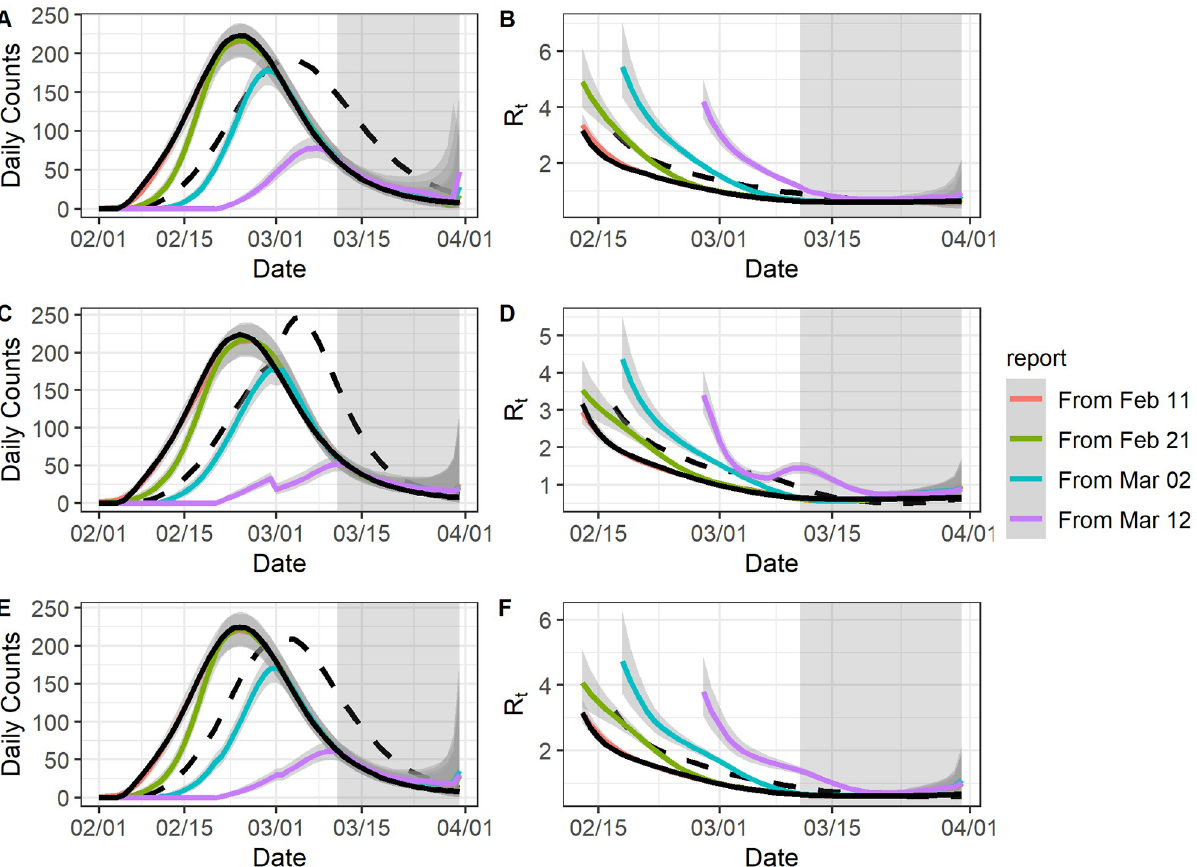
Fig 3. The model fit for data with no early report. For all graphs: the black solid curve corresponds to estimates based on the known epidemic curves and the black dashed curve corresponds to estimates based on the reported curves. The grey-shaded region superimposed on the curve depicts the 95% Bayesian credible interval and the grey-shade region on the right indicates the region of nowcasting. The colored curves represent different starting dates for the line-list data. All values were averaged over 1000 simulated datasets with the correct l . A: The epidemic curve estimates if the reporting delay distribution was unchanged. B: The reproduction number estimates if the reporting delay distribution was unchanged. C: The epidemic curve estimates if the reporting delay distribution was sharply improved. D: The reproduction number estimates if the reporting delay distribution was sharply improved. E: The epidemic curve estimates if the reporting delay distribution was gradually improved. F: The reproduction number estimates if the reporting delay distribution was gradually improved.